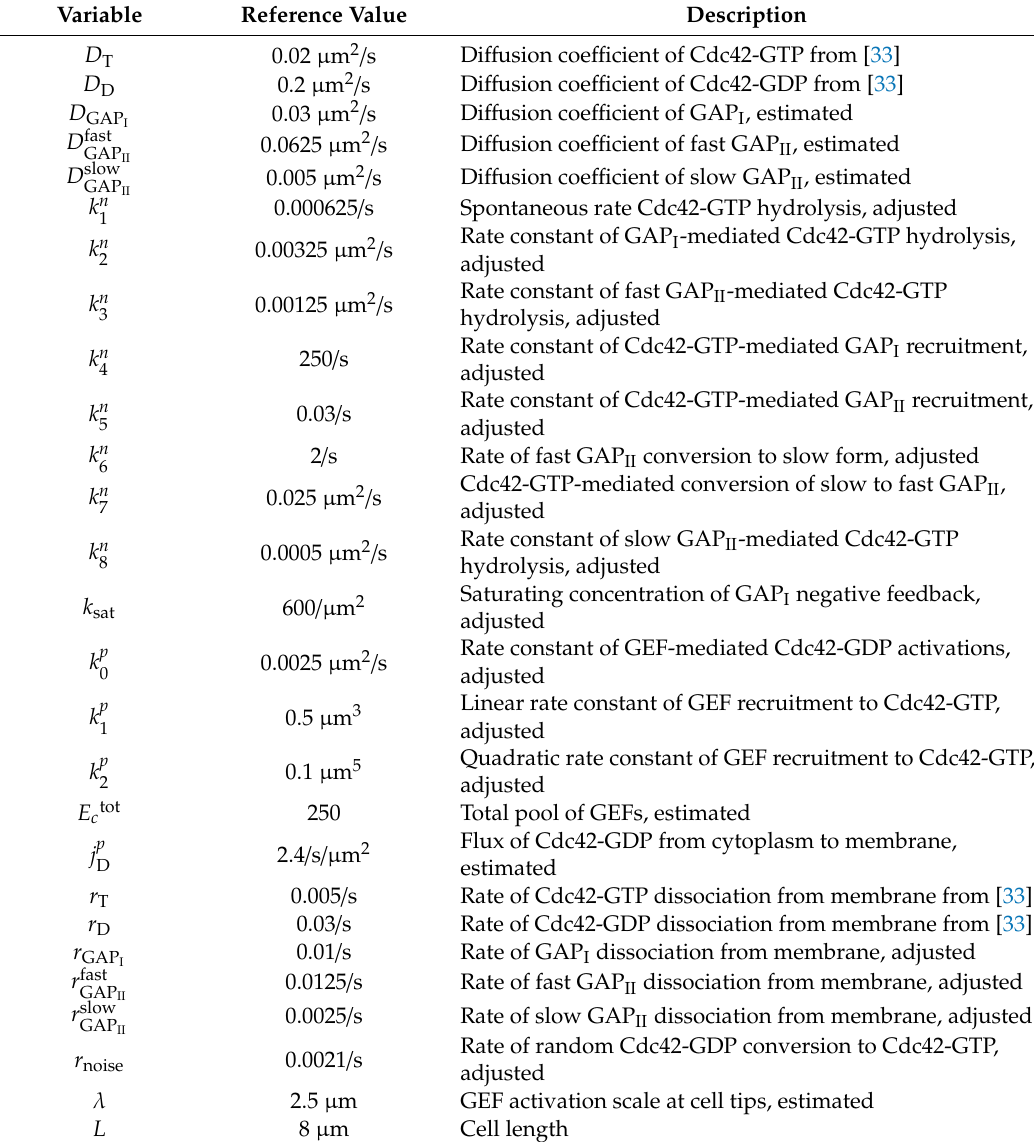
Table 1. List of parameters in reaction–di ff usion equations, their reference value in the simulations, and their physical meaning in the model. Unless indicated, the values were estimated or adjusted to match experimental observations as mentioned in the main